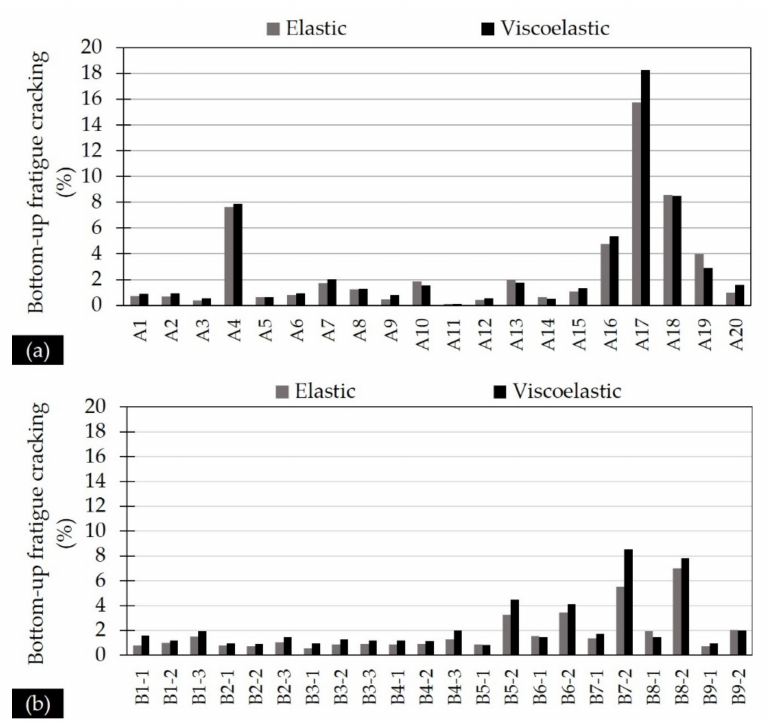
Figure 14. Alligator cracking prediction (bottom-up fatigue failure) for cross-sections at ( a ) pavement A and ( b ) pavement B.